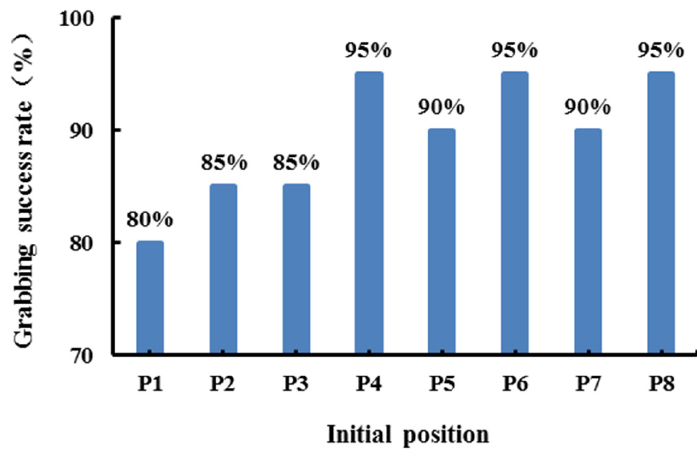
Figure 17. Grabbing success rate at different initial position P i . The grabbing success rate P s at different initial inclination angles, Φ o , are shown in